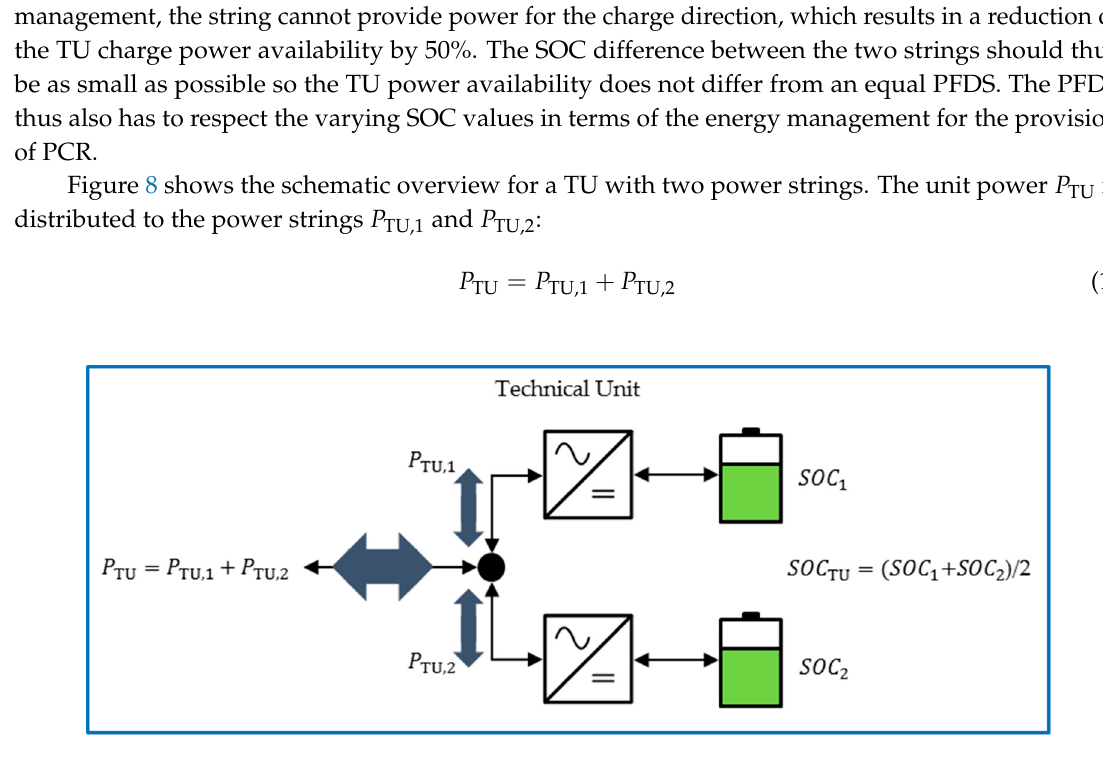
Figure 8. Schematic overview of a Technical Unit consisting of two power strings.